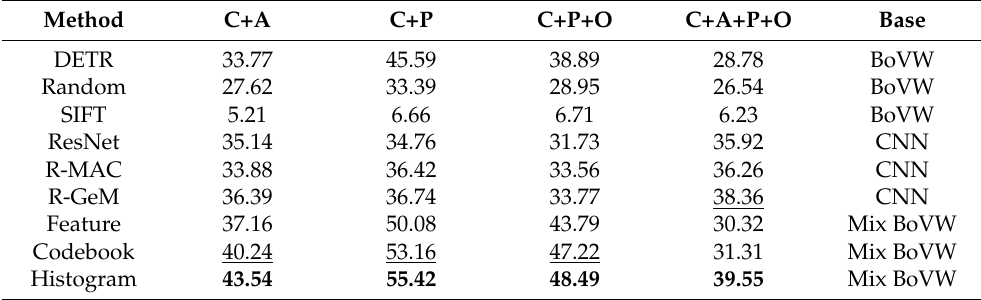
Table 2. Comparison of accuracy in a multi-subject dataset. The bold and underline mean the best and second accuracy for each dataset,